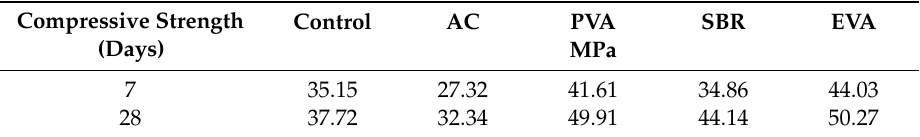
Table 5. Averaged compressive strengths measured at seven and 28